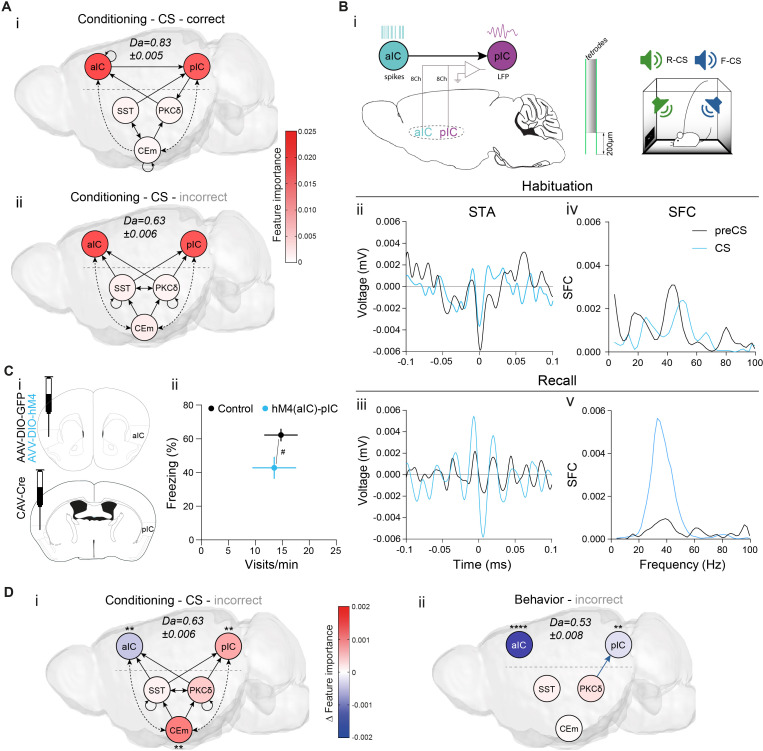
Learning establishes a performance-linked intra-cortical hierarchy.(A) TE networks generated from CSs during which correct (i) and incorrect/no (ii) behavior occurred during CS presentations. RF decoder accuracy (Da) for decoding correct/incorrect CSs shown above network. Node color corresponds to feature importance from RF classification. (B) (i) Scheme of recordings from aIC and pIC multi-site implanted animals, examined for interregional interactions at the habituation and recall stages. (ii, iii) STA from the (ii) habituation and (iii) recall stages of 200 ms pIC LFP traces centered around the occurrence of 2388 preCS/2526 CS (habituation) and 7132 preCS/6920 CS (recall) aIC spikes. (iv, v) pIC LFP power-normalized SFC of STAs for (iv) habituation and (v) recall. (C) (i) Experimental strategy for the chemogenetic inhibition of the aIC–pIC pathway. (ii) Quantification of behavioral performance in reward and fear domains at recall with a significant MANOVA (F1,18=3.64, p=0.0471), nControls=12, nM4(aIC)-pIC=9. Data shown as mean ± SEM. Holm post hoc as difference to control, #p<0.05. Full statistical report in Appendix 1—table 1. (D) (i) TE network of incorrect CS (from Aii), with node color showing contrast feature importance between incorrect and correct CS. * Depict significantly different feature importance (Figure 2—figure supplement 2Aii). RF Da for decoding incorrect CSs shown above network. (ii) TE network (from Figure 2Cii) with node color illustrating contrast feature importance between incorrect and correct behavioral episodes. * Depict significantly different feature importance (Figure 2—figure supplement 2Ai). RF Da for decoding incorrect behavioral episodes shown above network.Figure 3—source data 1.STA, SFC and associated approach and avoidance behavior in aIC–pIC interaction.